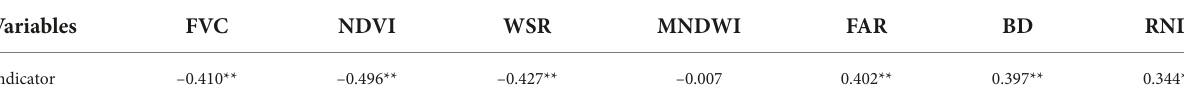
TABLE 3 The correlation of thermal environmental factors influences